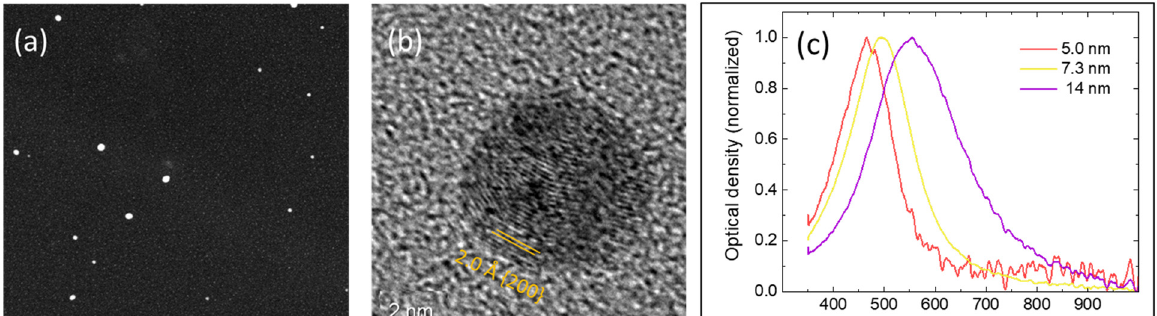
Figure 4. ( a ) Dark-field STEM image of silver NPs synthesized under the conditions denoted as case 1 (reference). ( b ) High-resolution image of a single silver NP showing the lattice planes belonging to the {200} family. ( c ) Optical absorption of silver NP ensembles with different average diameters as reported in the legend.